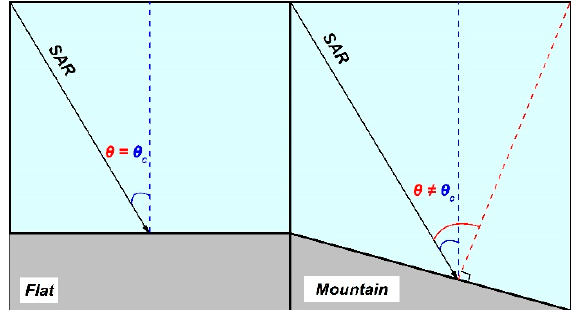
Figure 7. Diagram of the local incidence angle in flat and mountain areas. The red angle represents the local incidence angle θ , and the blue angle indicates the radar viewing angle θ c